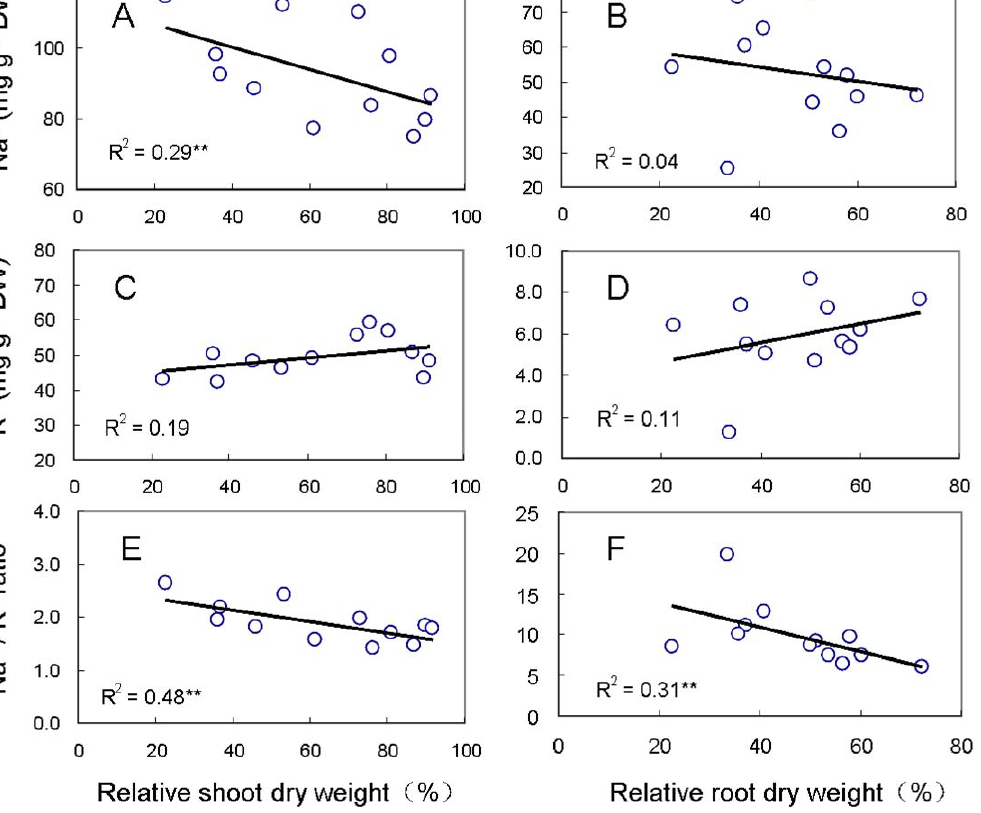
Figure 6. The correlation between relative dry weight and ionic contents. The correlation between Na + , K + contents and Na + /K + ratios and relative shoot (A, C and E) and root (B, D and F) dry weight is based on four genotypes: CM72, T16, T26 and T169, with three individuals for each genotype. doi:10.1371/journal.pone.0022938.g006 PLoS ONE |